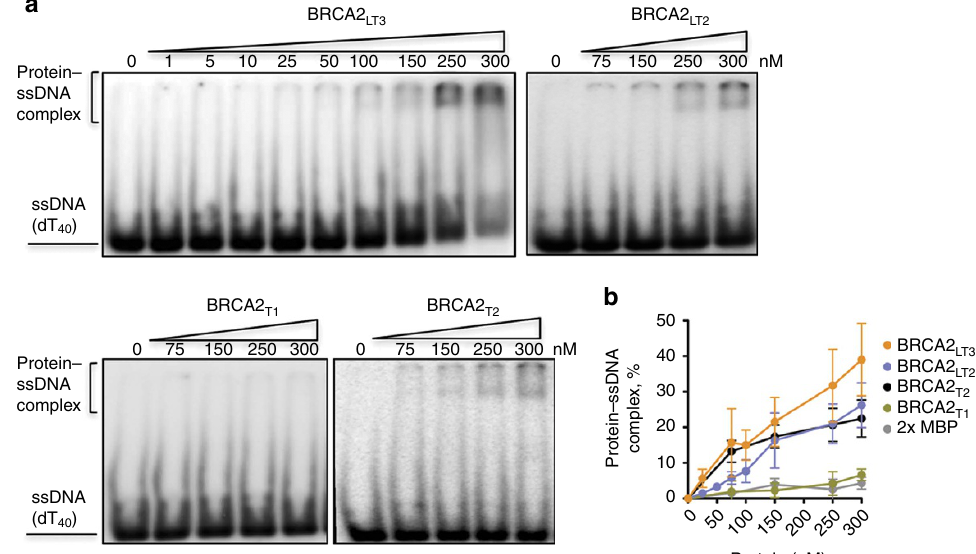
Figure 1 | The N terminus of BRCA2 binds DNA. ( a ) EMSA showing BRCA2 LT3 , BRCA2 LT2 , BRCA2 T1 and BRCA2 T2 binding to ssDNA (dT 40 ). ( b ) Quantification of a . Error bars, s.d. ( n ¼